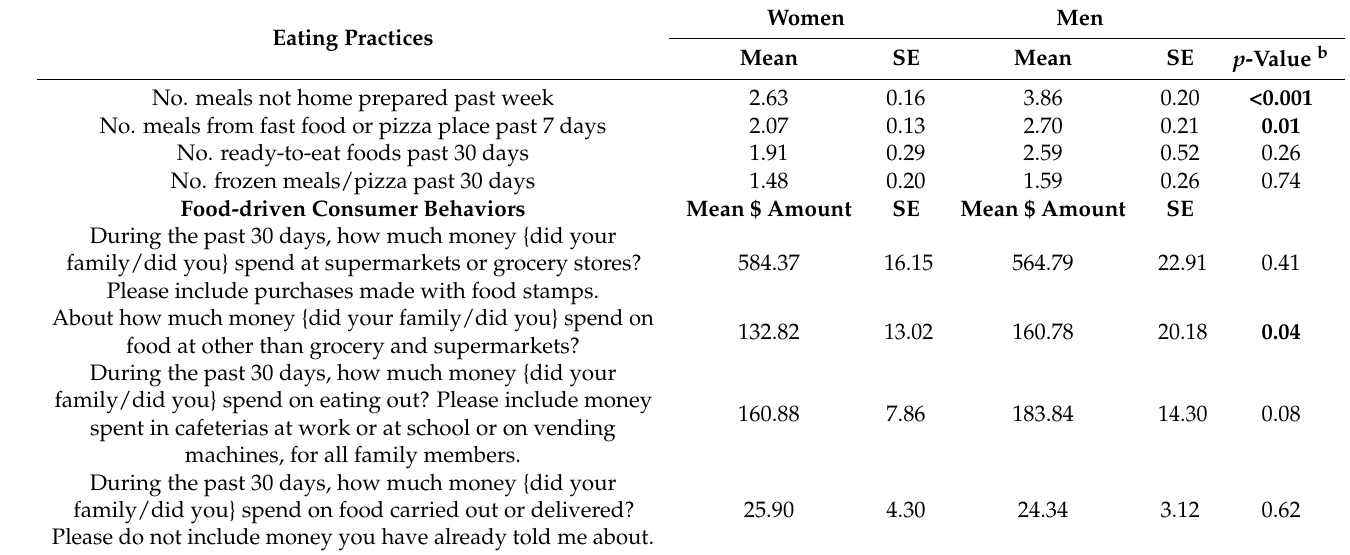
Table 4. Food-related practices among Hispanic/Latino women and men a . Eating